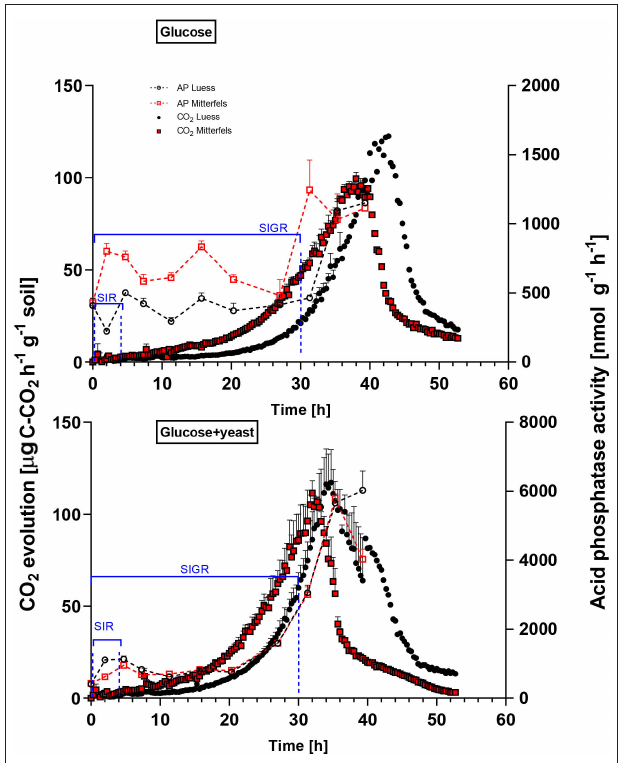
FIGURE 4 | Microbial growth curves and potential enzyme activities (dotted lines) are shown including SEM for soils treated with glucose vs. glucose + yeast extract. The nutrient-poor soil is denoted by black circles, whereas nutrient-rich soil is highlighted in red squares. The values given at time point zero, reflected the control, namely without the addition of any substrate. The time interval chosen for calculation of SIR are denoted in blue brackets. For kinetic parameters of SIGR, the whole curve including lag phase is required for modeling, which is also shown in blue.